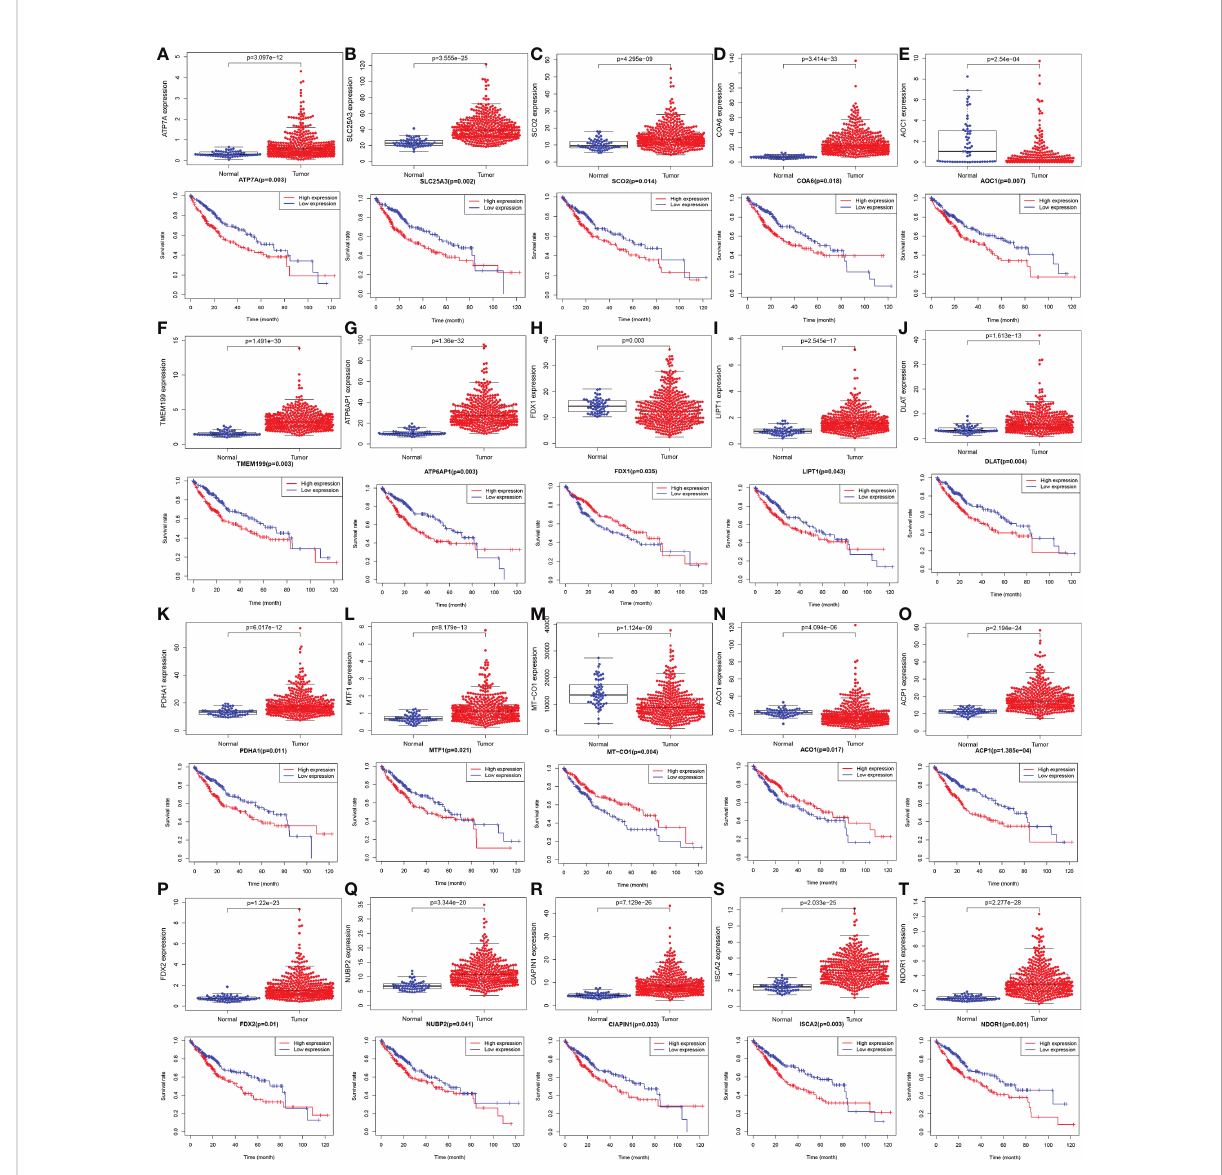
FIGURE 2 The boxplot and Kaplan-Meier survival curves with mRNA expression of screened cuproptosis-related genes in hepatocellular carcinoma (HCC) from the TCGA database. Different expression of cuproptosis-related genes between HCC tumor and normal tissues, including ATP7A (A) , SLC25A3 (B) , SCO2 (C) , COA6 (D) , AOC1 (E) , TMEM199 (F) , ATP6AP1 (G) , FDX1 (H) , LIPT1 (I) , DLAT (J) , PDHA1 (K) , MTF1 (L) , MT- CO1 (M) , ACO1 (N) , ACP1 (O) , FDX2 (P) , NUBP2 (Q) , CIAPIN1 (R) , ISCA2 (S) , and NDOR1 (T) . The association between survival rate and expression levels of cuproptosis-related genes in HCC, including ATP7A (A) , SLC25A3 (B) , SCO2 (C) , COA6 (D) , AOC1 (E) , TMEM199 (F) , ATP6AP1 (G) , FDX1 (H) , LIPT1 (I) , DLAT (J) , PDHA1 (K) , MTF1 (L) , MT- CO1 (M) , ACO1 (N) , ACP1 (O) , FDX2 (P) , NUBP2 (Q) , CIAPIN1 (R) , ISCA2 (S) , and NDOR1 (T) . (ACO1, aconitase 1; ACP1, acid phosphatase 1; AOC1, amine oxidase copper containing 1; ATP6AP1, ATPase H+ transporting accessory protein 1; ATP7A, copper-transporting p-type adenosine triphosphatase 1; CIAPIN1, cytokine induced apoptosis inhibitor 1; COA6, cytochrome c oxidase assembly factor 6; DLAT, dihydrolipoamide S-acetyltransferase; FDX1, ferredoxin 1; FDX2, ferredoxin 2; HCC, hepatocellular carcinoma; ISCA2, iron-sulfur cluster assembly 2; LIPT1, lipoyltransferase 1; MT-CO1, mitochondrially encoded cytochrome c oxidase I; MTF1, metal regulatory transcription factor 1; NDOR1, NADPH dependent di fl avin oxidoreductase 1; NUBP2, nucleotide binding protein 2; PDHA1, pyruvate dehydrogenase E1 subunit alpha 1; SCO2, synthesis of cytochrome c oxidase 2; SLC25A3, solute carrier family 25 member 3; TCGA, The